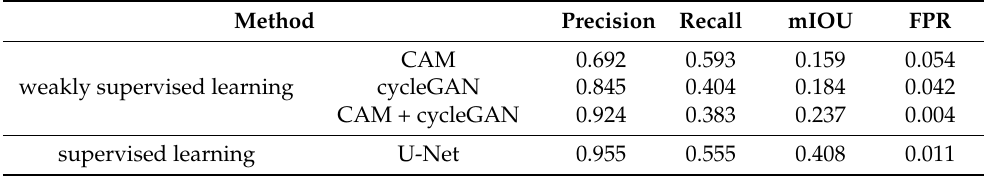
Table 1. Comparison of test results between weakly supervised learning and supervised learning.